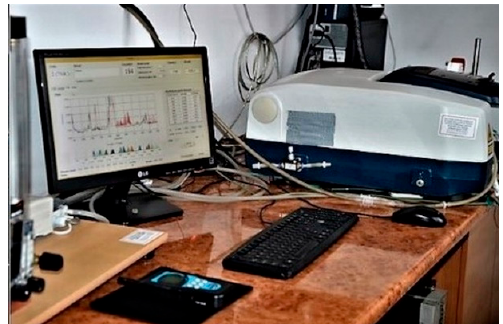
Figure 3. Stand for testing the toxicity of combustion products using a method according to PN-B-02855 used in Sychta Laboratory [56].